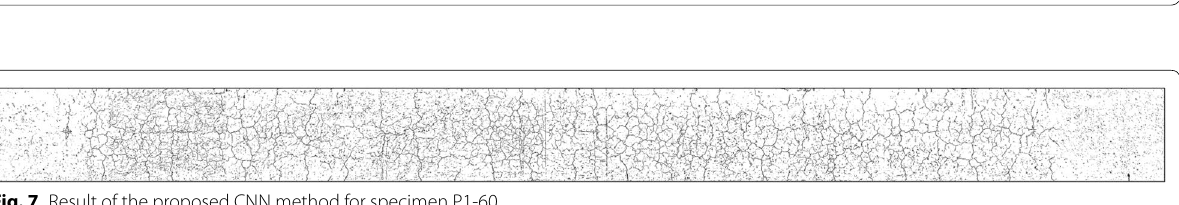
Fig. 6 Examples of input crack images in the first column and the output images from weighting feature network, low-level feature network, and the final output in the second, third, and fourth column, respectively (Kim et al. 2018).